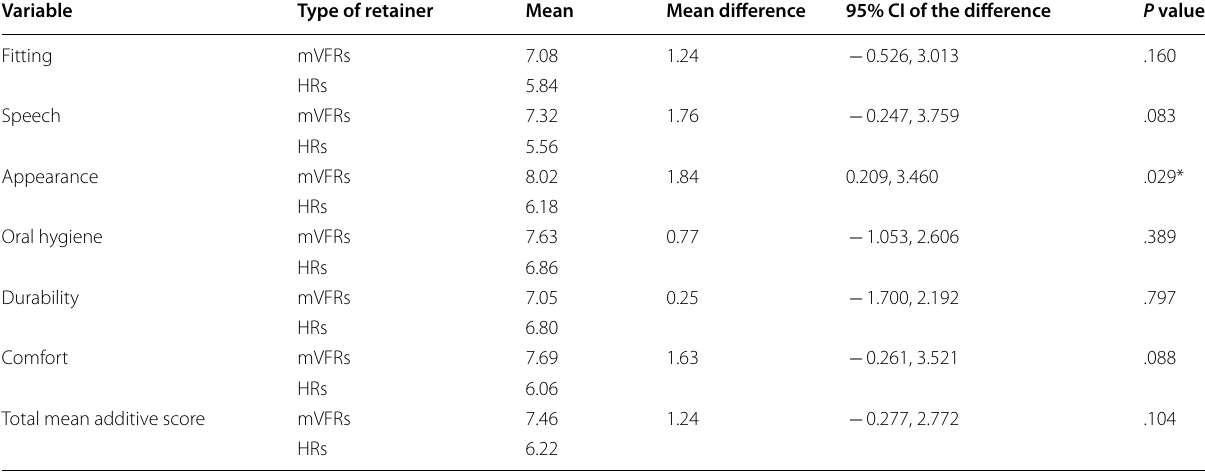
mVFRs indicate modified vacuum-formed retainers; HRs, Hawley retainers; CI, confidence interval Level of significance set at 0.05. *Significant P values